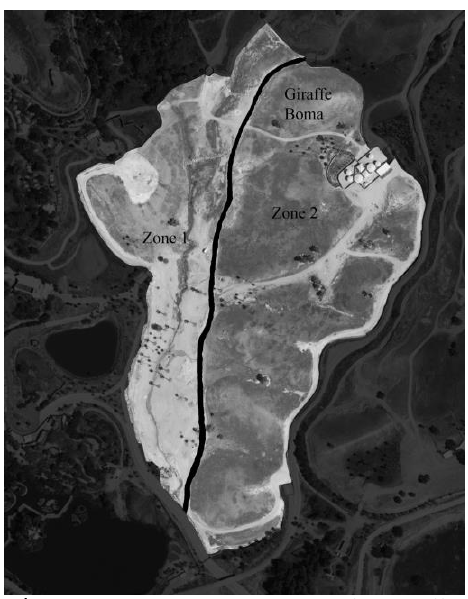
Figure 1 . Map detailing the location of the giraffe boma and two different zones for the